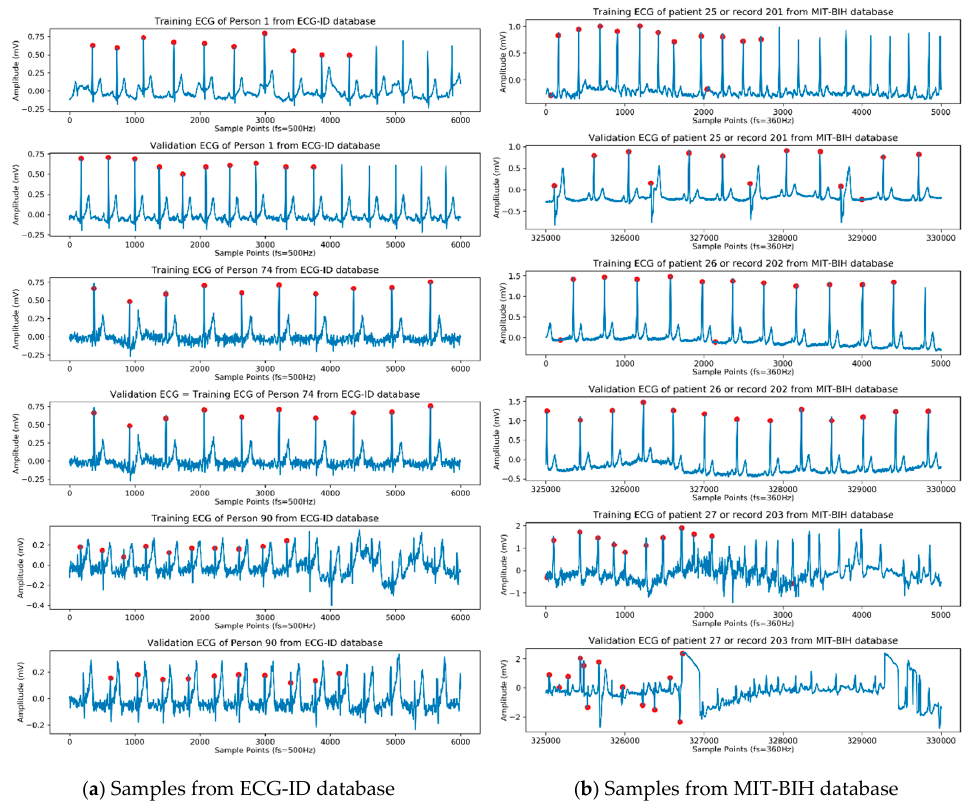
Figure 2. Sample of ECG records of three people obtained from the ECG-ID (the 1st, 74th, and 90th person) and MIT-BIH (the 25th, 26th, and 27th person) databases. The red dots were the R peak positions annotated manually by cardiologists.